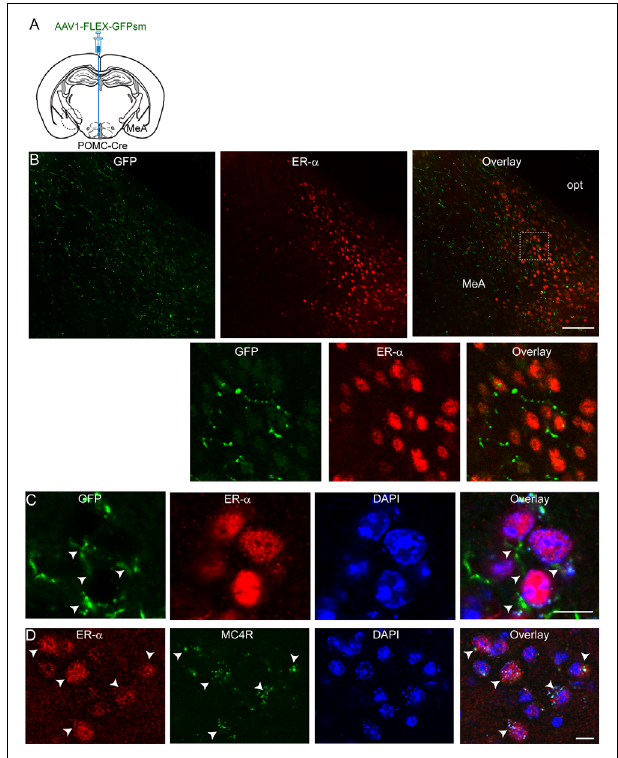
FIGURE 2 | ARC POMC neurons project to ER- α -expressing cells in the MeA. (A) Schematic illustration of our experimental configurations. AAV1-FLEX-GFPsm was stereotaxically injected into the ARC of the POMC-Cre mice. (B) Images of fluorescence confocal microscopy showing that ARC POMC neurons send projections to ER- α -positive cells (top panel). GFP-positive fibers and axonal terminals were observed in the MeA where FIGURE 1 | Proopiomelanocortin neurons in the arcuate nucleus of the ER- α -positive cells were located. Scale bar: 100 µ m. Bottom panel: images hypothalamus project to the medial amygdala (MeA). (A) Schematic on the expanded scale (white square area in the top panel). (C) Images of illustration showing our experimental configurations (left panel). A Cre fluorescence confocal microscopy showing that ER- α -positive cells receive recombinase-inducible anterograde viral tracer AAV1-FLEX-GFPsm was POMC input from the ARC. GFP-positive fibers and axonal terminals made injected into the ARC of the POMC-Cre mice. Right panel: The ARC of the synaptic contacts with a subset of ER- α -positive cells (white arrowheads). POMC-Cre mice injected with AAV1-FLEX-GFPsm exhibited GFP-positive Scale bar: 10 µ m. (D) Images of fluorescence confocal microscopy showing cells in the ARC. Scale bar: 30 µ m. (B) Image of fluorescence confocal co-expression of ER- α and MC4Rs (white arrows). Scale bar: 10 µ microscopy showing GFP-positive fibers and terminals in the MeA of the POMC-Cre mice injected with AAV1-FLEX-GFPsm. opt, optic tract, Scale bar: 100 µ m. (C) Images of fluorescence confocal microscopy showing co-expression of GFP and ACTH in axonal fibers in the MeA (white arrow). Scale bar: 20 µ m. (D) Schematic illustration showing our experimental configurations (top panel). POMC-Cre; eGFP mice were stereotaxically injected with a Cre-inducible retrograde viral tracer retroAAV-FLEX-tdTomato into the MeA. TdTomato-positive fibers were observed in the MeA (bottom panel). Scale bar: 200 µ m. (E) Images of fluorescence confocal microscopy showing retrogradely identified ARC POMC neurons projecting to the MeA. Retrogradely identified cells (white arrow) were found in the ipsilateral, but not contralateral, ARC of the POMC-Cre; eGFP mice injected with retroAAV-FLEX-tdTomato. Importantly, most tdTomato-positive cells were found in the lateral part of the ARC. Scale bar: 50 µ m. (F) Images of fluorescence confocal microscopy showing retrogradely labeled ARC POMC neurons. Most tdTomato neurons co-expressed GFP in the POMC-Cre; eGFP mice injected with retroAAV-FLEX-tdTomato into the MeA (white arrow). Scale bar: 30 µ m. (G) Schematic drawing showing the location of retrogradely identified cells (x) in the ARC. 3V, 3rd ventricle. showing SIM1 neurons in the MeA express ER- α as well as MC4Rs (Balthasar et al., 2005;